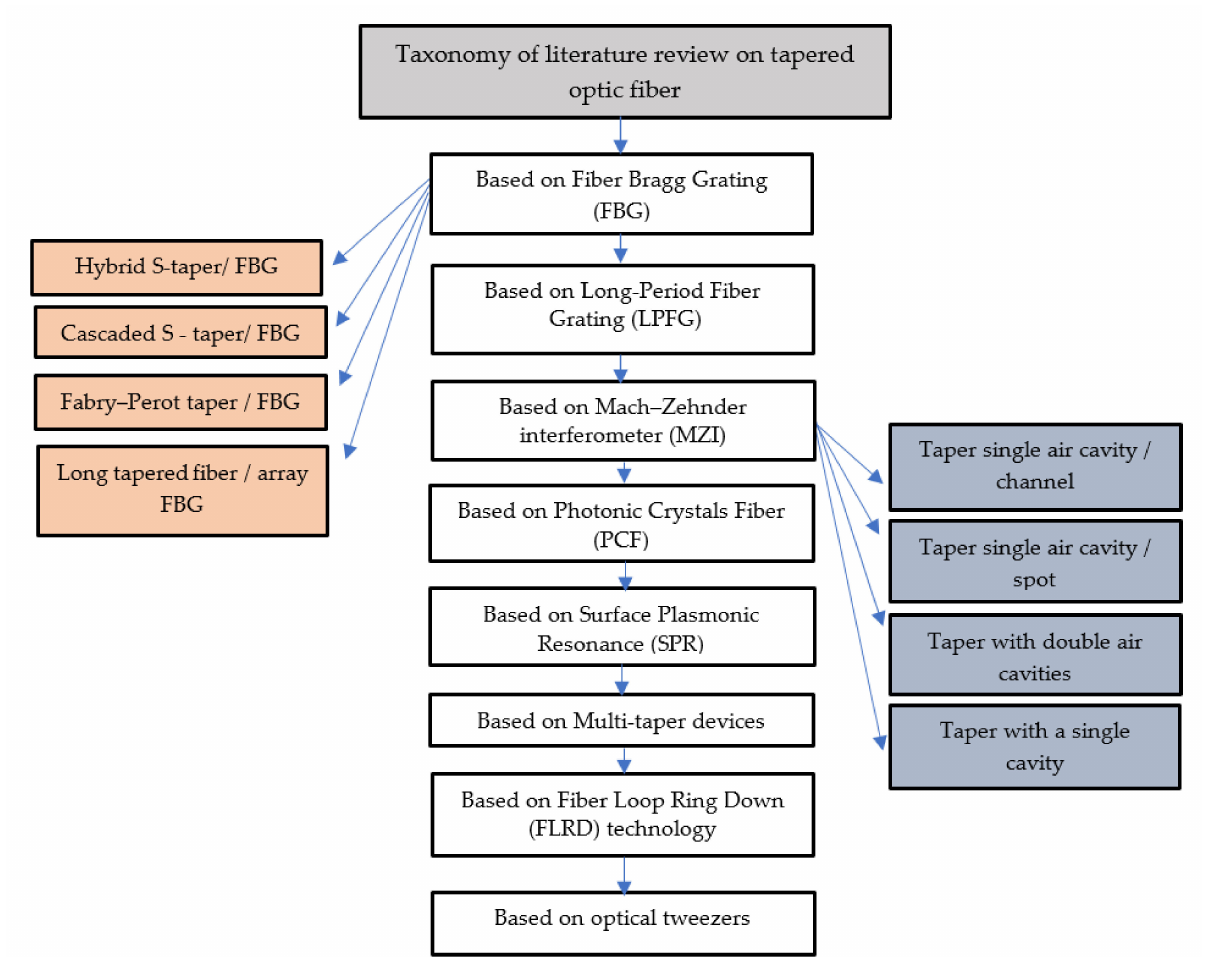
Figure 2. Taxonomy of literature research on tapered optic